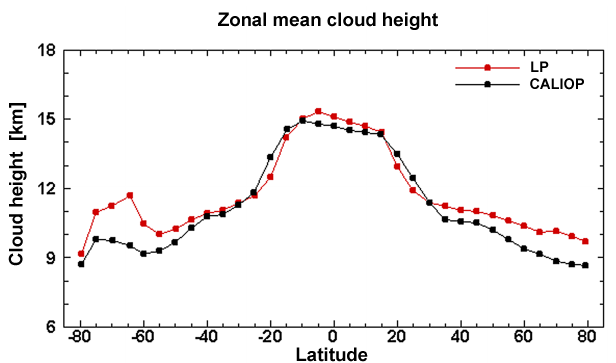
Figure 6. Zonal mean cloud height calculated from LP cloud de- tection algorithm results (red line) and collocated CALIPSO data (black line) in 5 ◦ latitude bands. Results averaged over 70 sample days between April 2012 and February 2015. Figure 7. Normalized frequency histogram of all cloud height dif- ferences (LP − CALIPSO) from coincidence data sets in (cid:49)z cloud = 1km intervals. The red curve represents a Gaussian fit to the